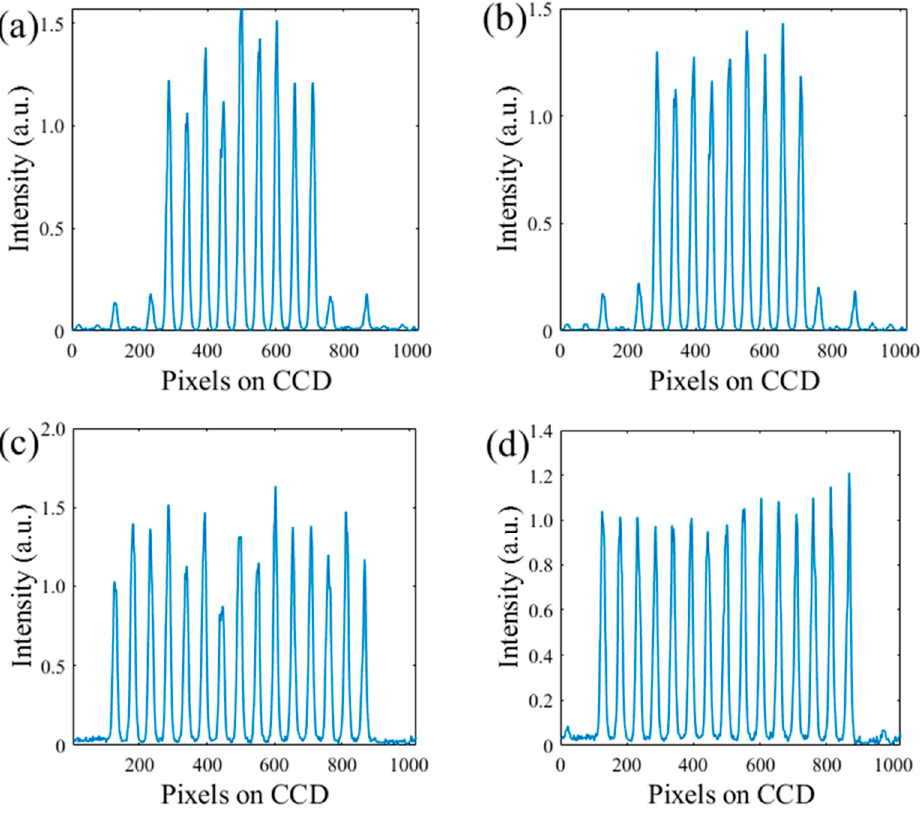
Figure 9. The original and result generated beam spot array for 1 × 9 ( a , b ) and 1 × 15 ( c , d ) in the experiment.